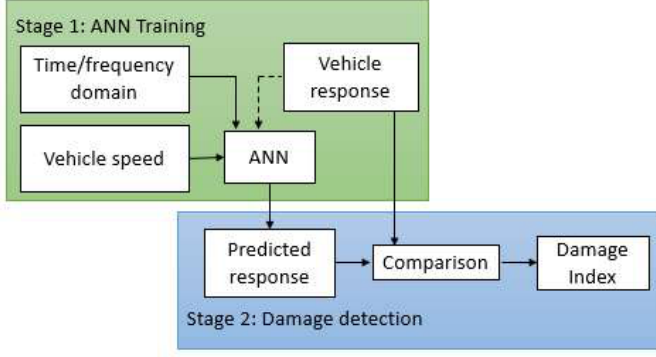
Figure 1. The proposed algorithm.